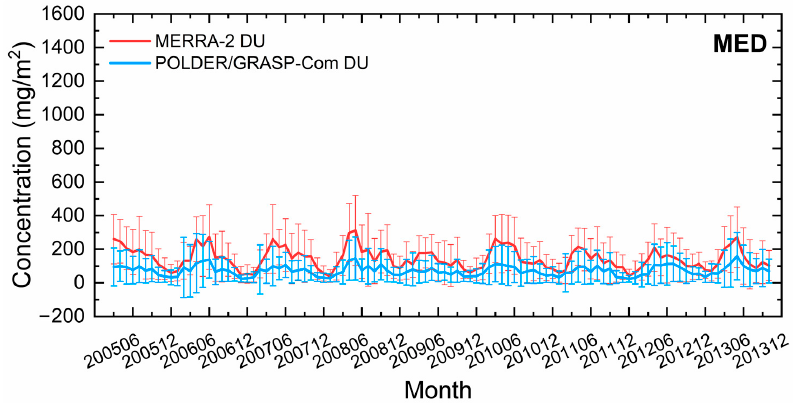
Figure 10. Same as Figure 3, but for Mediterranean Basin (MED)